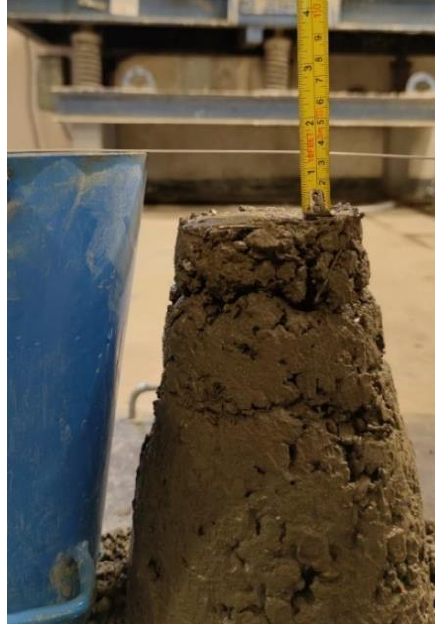
Figure 1. Slump test of the M 3 concrete mix.